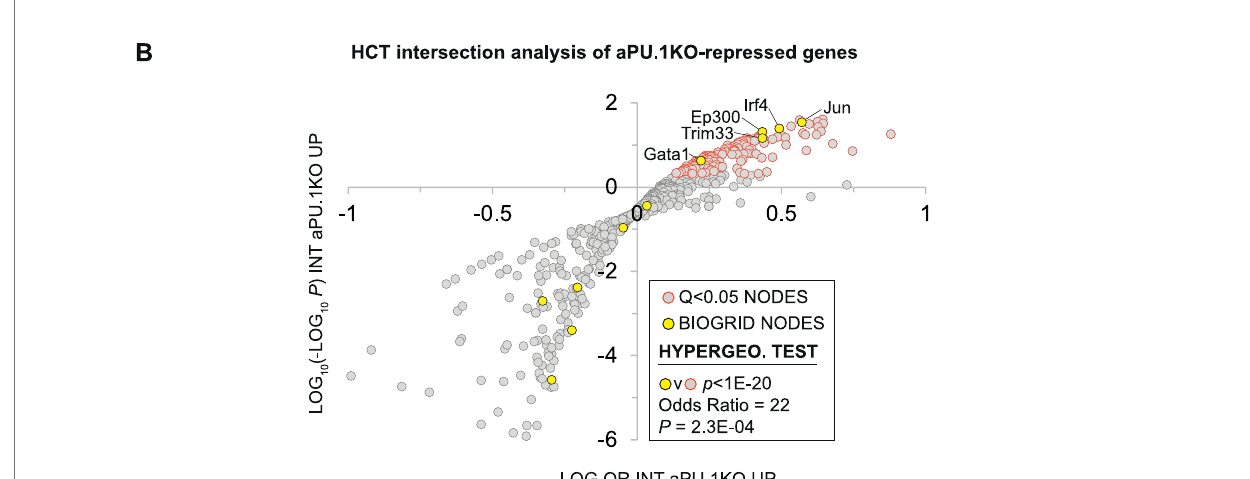
Frontiers in Aging |